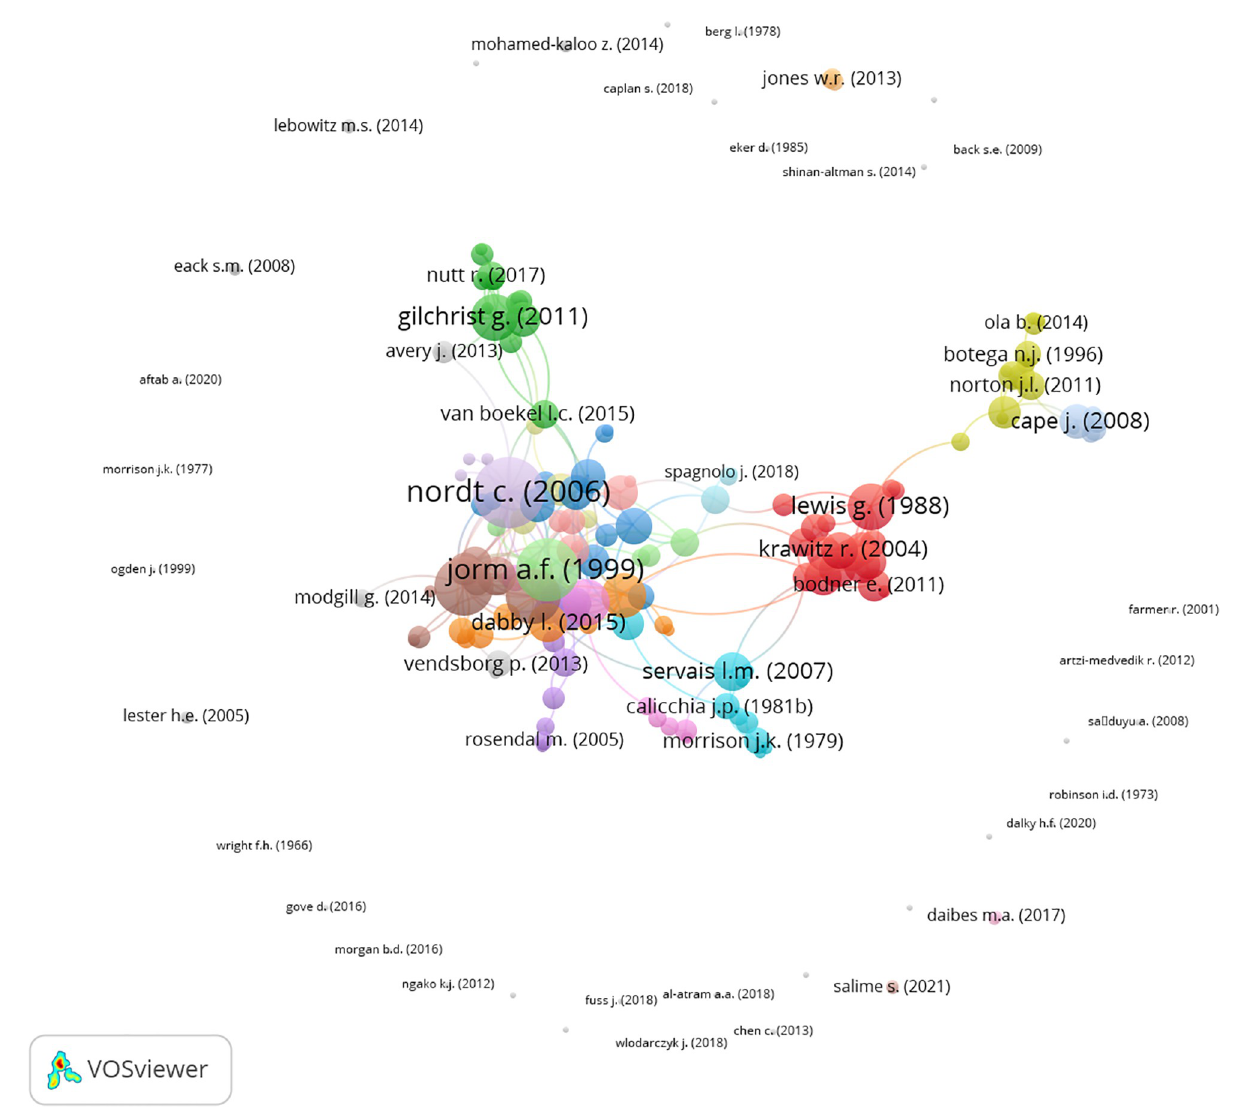
Fig 2. Global citation